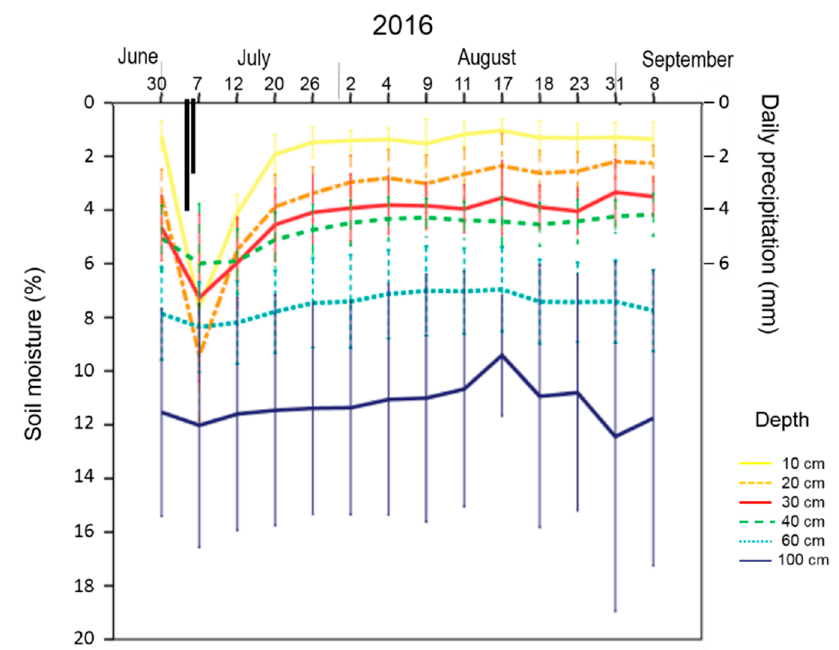
Figure 3. Average (lines) and standard deviation (vertical lines) of instantaneous soil moisture measured at six depths in all the locations from the experimental plot, and daily precipitation (black bars) during summer 2016.